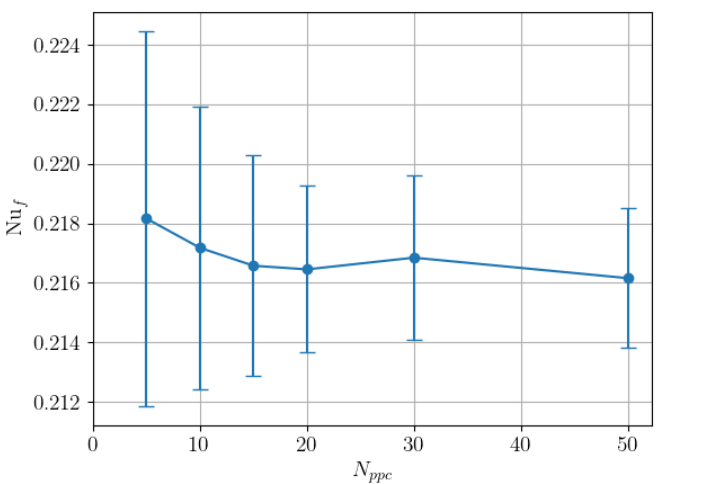
Figure 3. Schematic of the domain used for DSMC simulations. Domain size is fully defined in terms of the length L as shown. Collision cell width and height ( L c ) is approximately half of the mean free path evaluated at the film temperature ( λ f ).